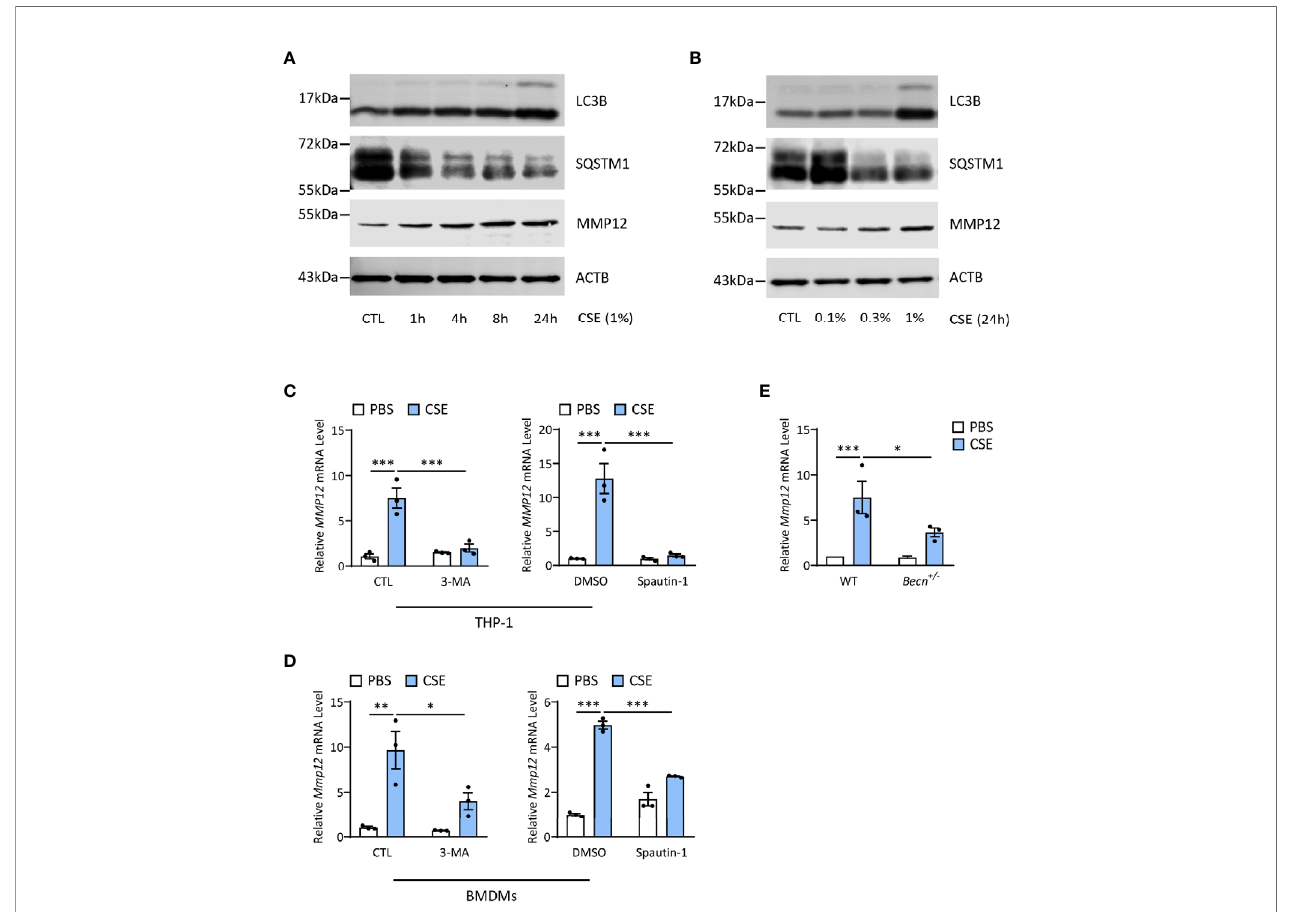
FIGURE 6 | Autophagy promotes CS-induced MMP12 expression in macrophages. (A) Representative immunoblots of time-dependent expression of LC3B and MMP12 in THP-1 cells exposed to 1% CSE. (B) Representative immunoblots dose-dependent expression of LC3B and MMP12 in THP-1 cells exposed to CSE for 24 h. (C) Expression of MMP12 mRNA transcripts in THP-1 cells treated with 3-MA (4 mM) or Spautin-1 (10 m M) along with 1% CSE for 24 h. (D) Expression of Mmp12 mRNA transcripts in BMDMs treated with 3-MA (4 mM) or Spautin-1 (10 m M) along with 1% CSE for 24 h. (E) Expression of Mmp12 mRNA transcripts in BMDMs from Becn +/- mice. Throughout, data were replicated in at least 3 independent experiments. Data are presented as mean ± s.e.m. * p < 0.05, ** p < 0.01, *** p < 0.001 by one-way